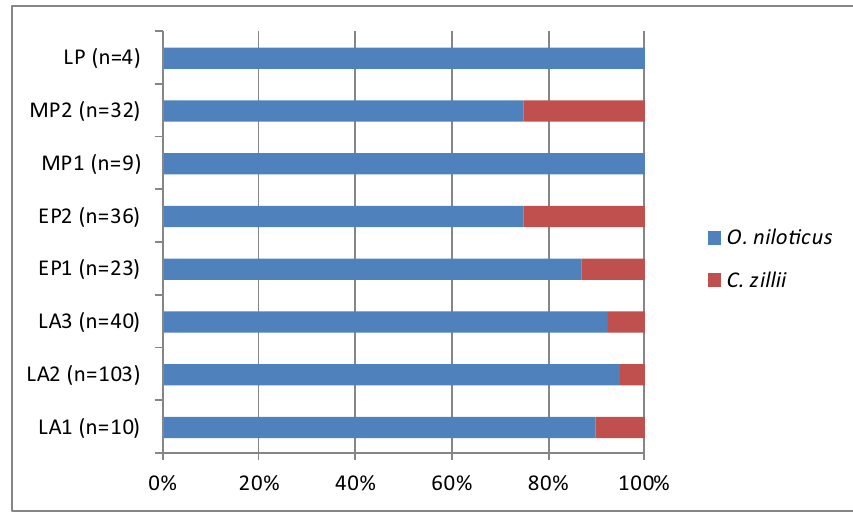
Fig 11. Proportions of the two tilapia species ( Oreochromis niloticus and Coptodon zillii ) in the various chronological phases. For each period the number of remains (n) is indicated on which the percentages are calculated.